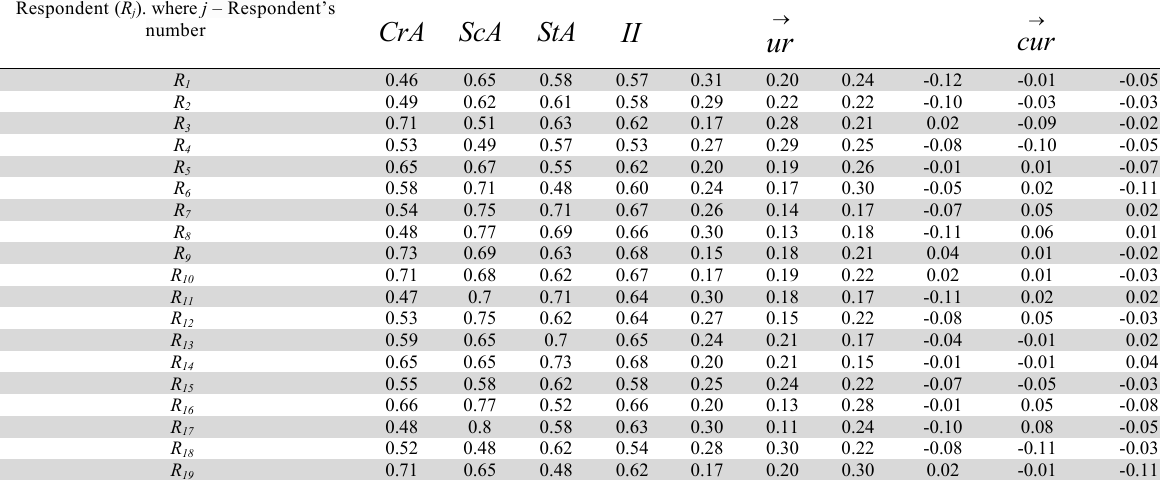
Results on personal human capital